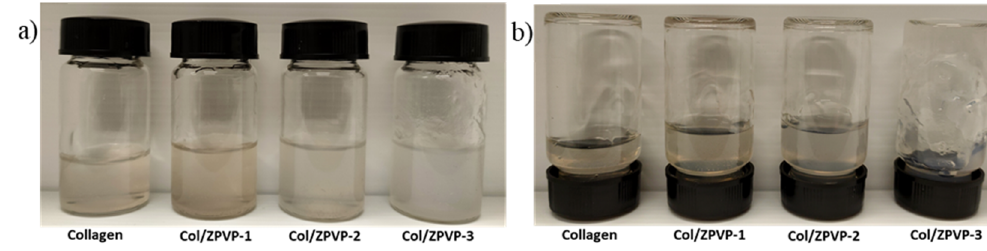
Figure 1. ( a ) Physical appearance of collagen, Col/ZPVP-1 (1:0.25), Col/ZPVP-2 (1:0.5), Col/ZPVP-3 (1:1) and ( b ) flow behavior when vials are inverted by 180°. Images were taken at room temperature.